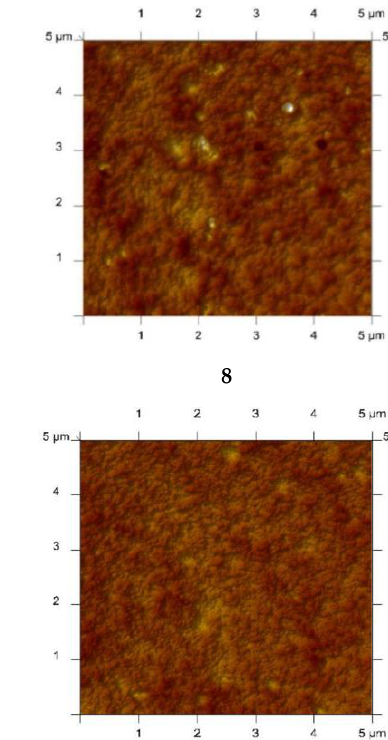
14 Figure 9. SEM-views of PIMs with 1-octylimidazole ( 3 ), 1-octyl-2-methylimidazole ( 8 ), 1-octyl-4-methylimidazole ( 12 ), and 1-octyl-2,4-dimethylimidazole ( 14 ) [61].